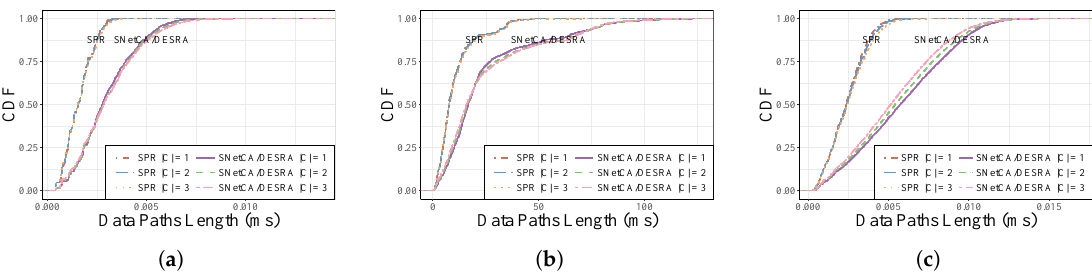
Figure 9. Cumulative distribution function of data paths latency varying the amount of controllers in the: ( a ) New York topology; ( b ) Geant topology; and ( c ) Norway topology.